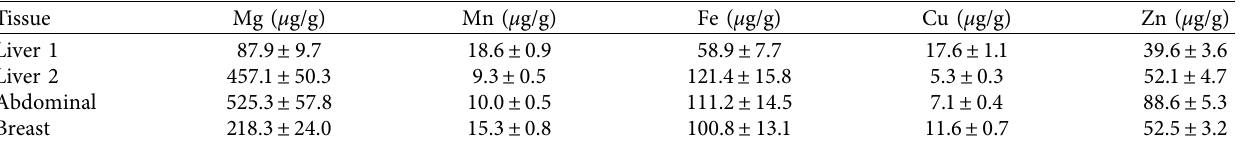
Table 2: Predicted concentration values of copper, manganese, magnesium, iron, and zinc in liver tissues using the artificial neural network multivariate calibration